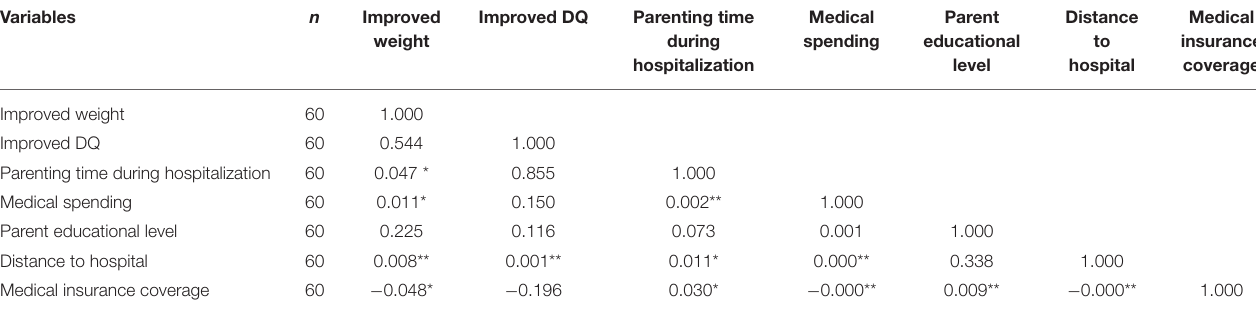
TABLE 3 | Correlation